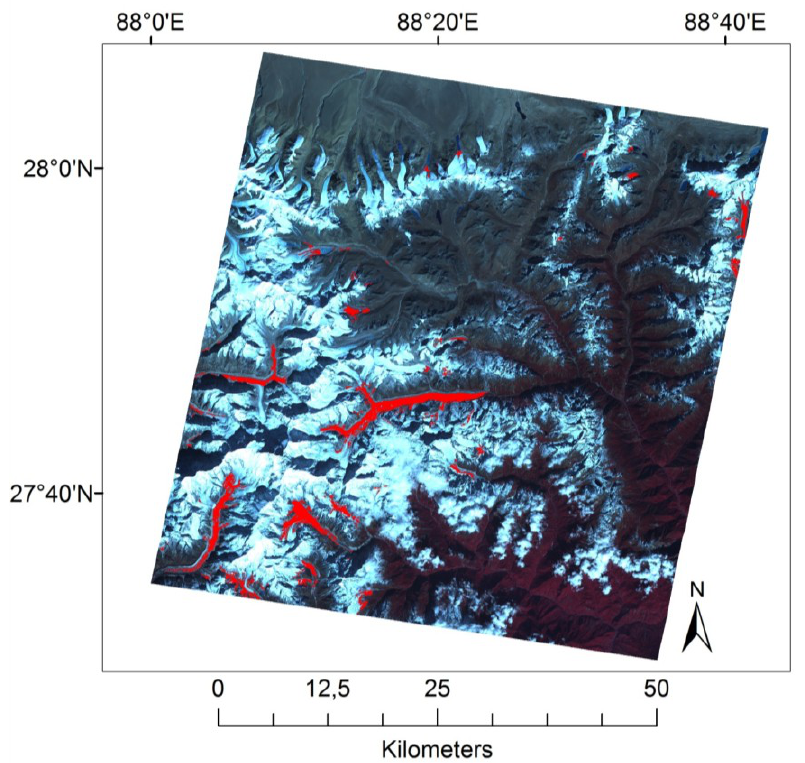
Figure 9. Results of the decision tree classification for the 2001 ASTER scene. Potential debris covered ice is shown in red, and is overlayed on a 321 color composite of the ASTER